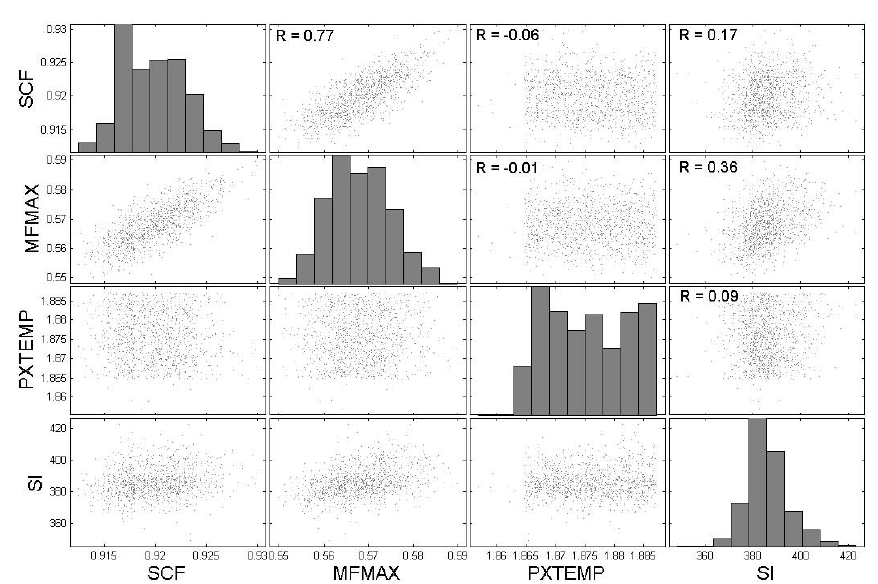
Fig. 6. Marginal distributions (in bars) and scatter plots (in dots) for posterior SNOW17 parameters. R signifies the linear correlation between